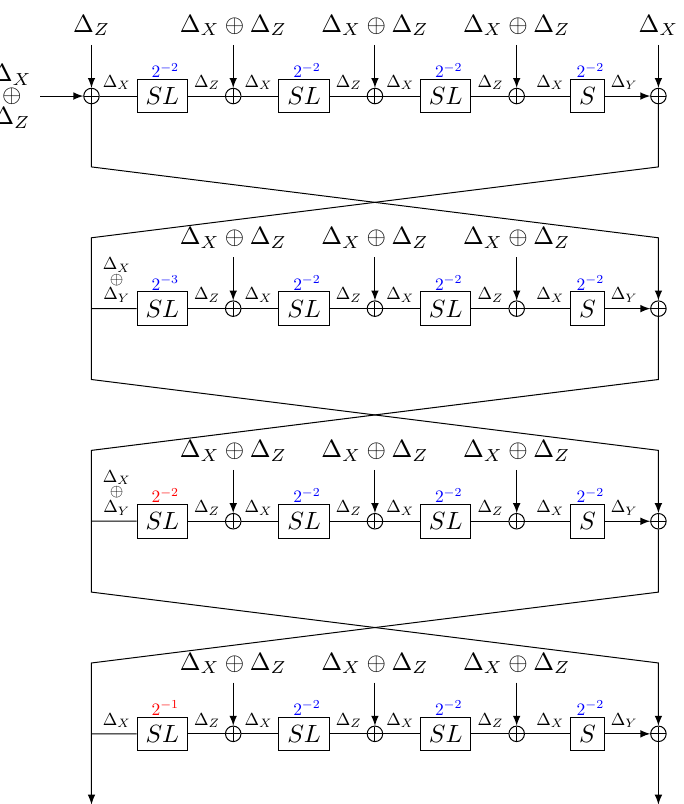
Figure 5: 4-round iterative characteristic for RoadRunneR -80. ∆ X = 0x5 , ∆ Y = 0xA , ∆ Z = L (∆ Y ). The transition probabilities in red are those which differ from the estimate with the independent S-box